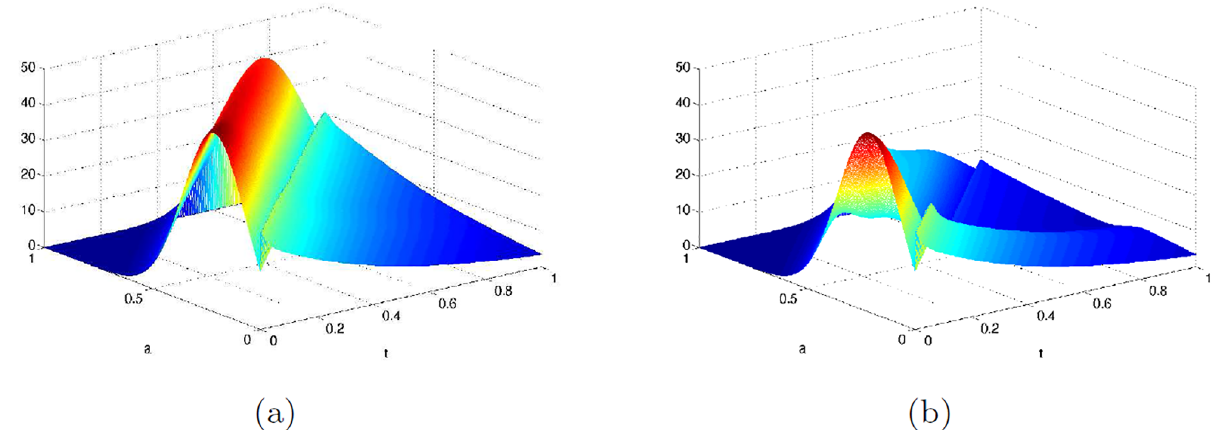
Fig 3. Simulations of model (1) with time ( t ) and age ( a ) scaled to [0, 1]. In the graphs, age ( a ), and time ( t ) denote the dimensionless age and time, respectively, ranging from [0, 1] with a , t = 1 corresponding to 350 years. (a): Scaled age-structured profile of trees when endemic beetles’ state occur. (b): Scaled age-structured profile of trees when epidemic state of beetles’ state occur.